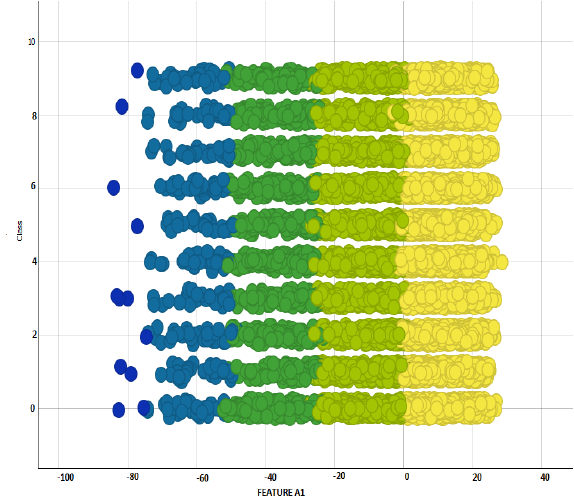
Figure 12. Scatter plot showing the features (first two principal components) of pooling layer of proposed approach of SFDDD dataset for driver distraction detection including safe driving, texting— right, talking on the phone—right, texting—left, talking on the phone—left, operating the radio, drinking, reaching behind, hair and makeup, and talking to a passenger.